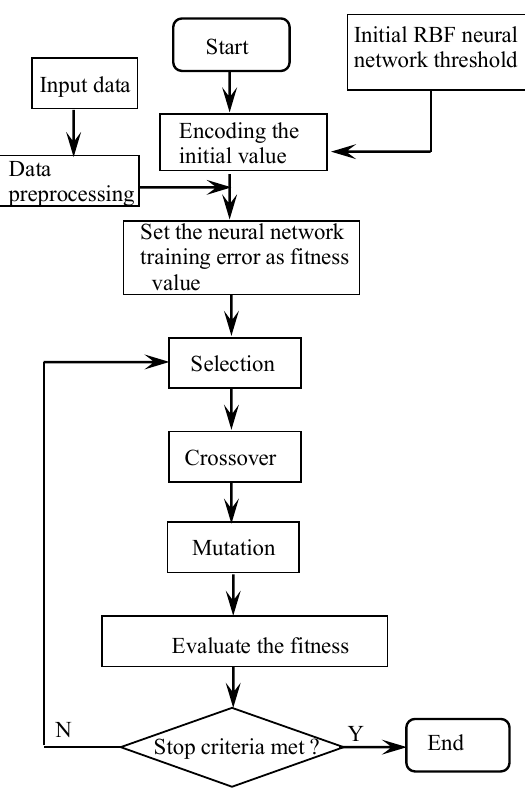
Figure 5. The solving process of the GA. The adaptability variation curve during the process of optimizing the cutting speed, cutting depth, rake angle, and rounded edge radius is shown in Figure 6.